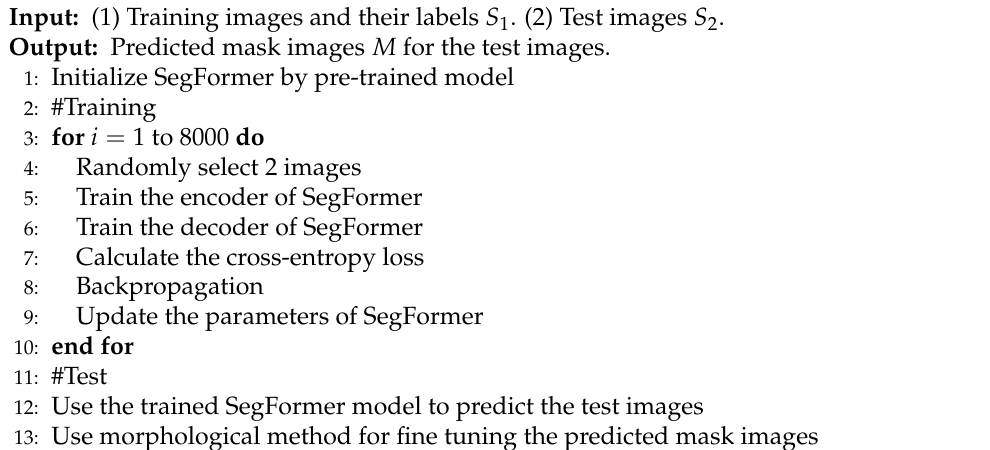
Algorithm 1 Landslide recognition using